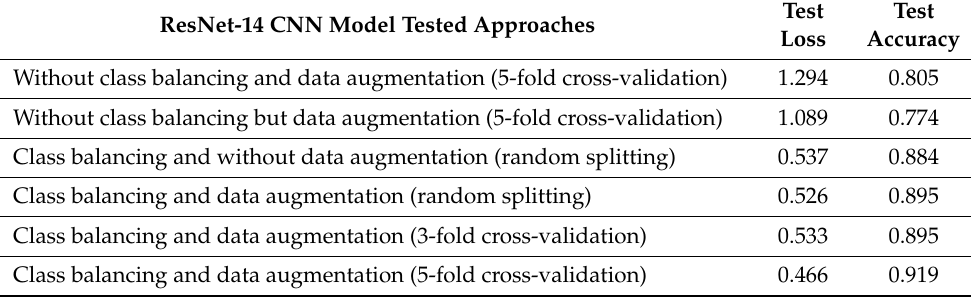
Table 5. The ResNet-14 CNN test loss and test accuracy.